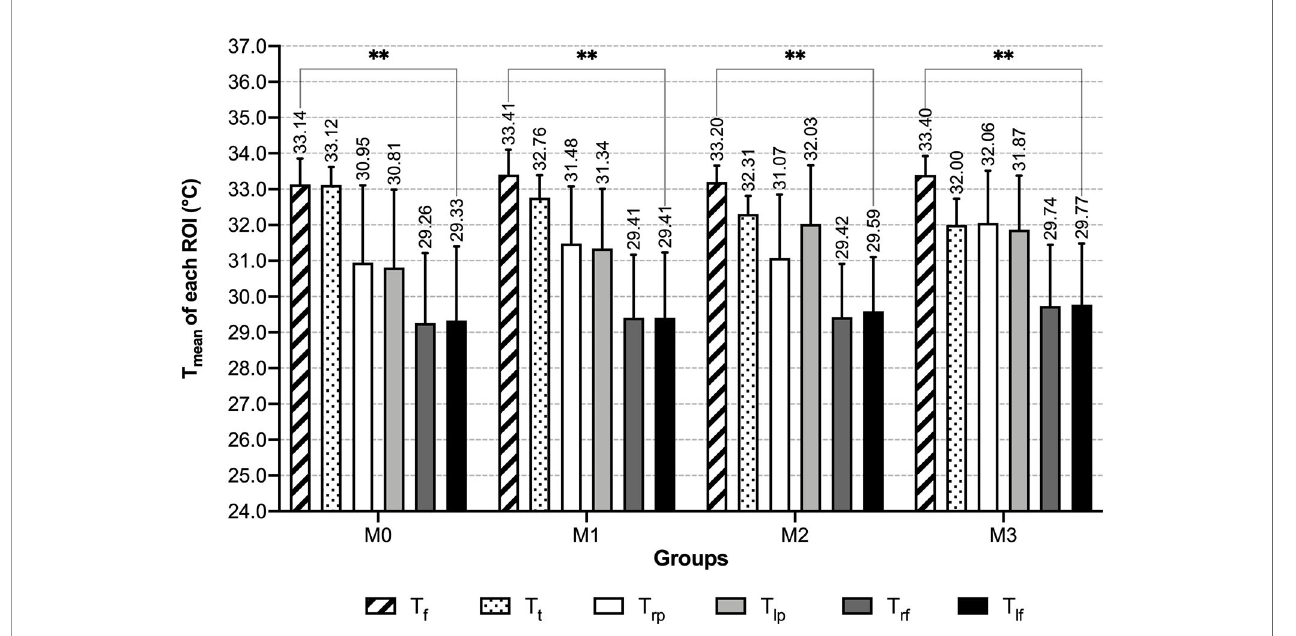
FIGURE 4 | T mean of each ROI of male groups - grouped by number of abnormal indexes. **: P <